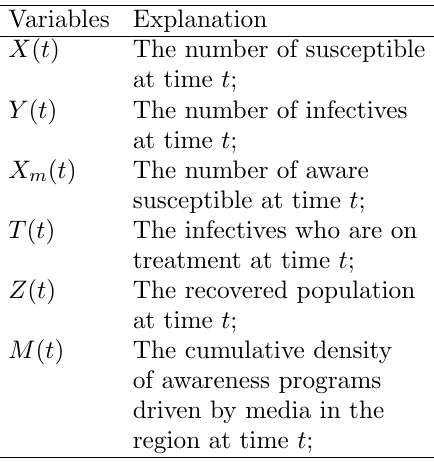
Table 1. Description of variables of the